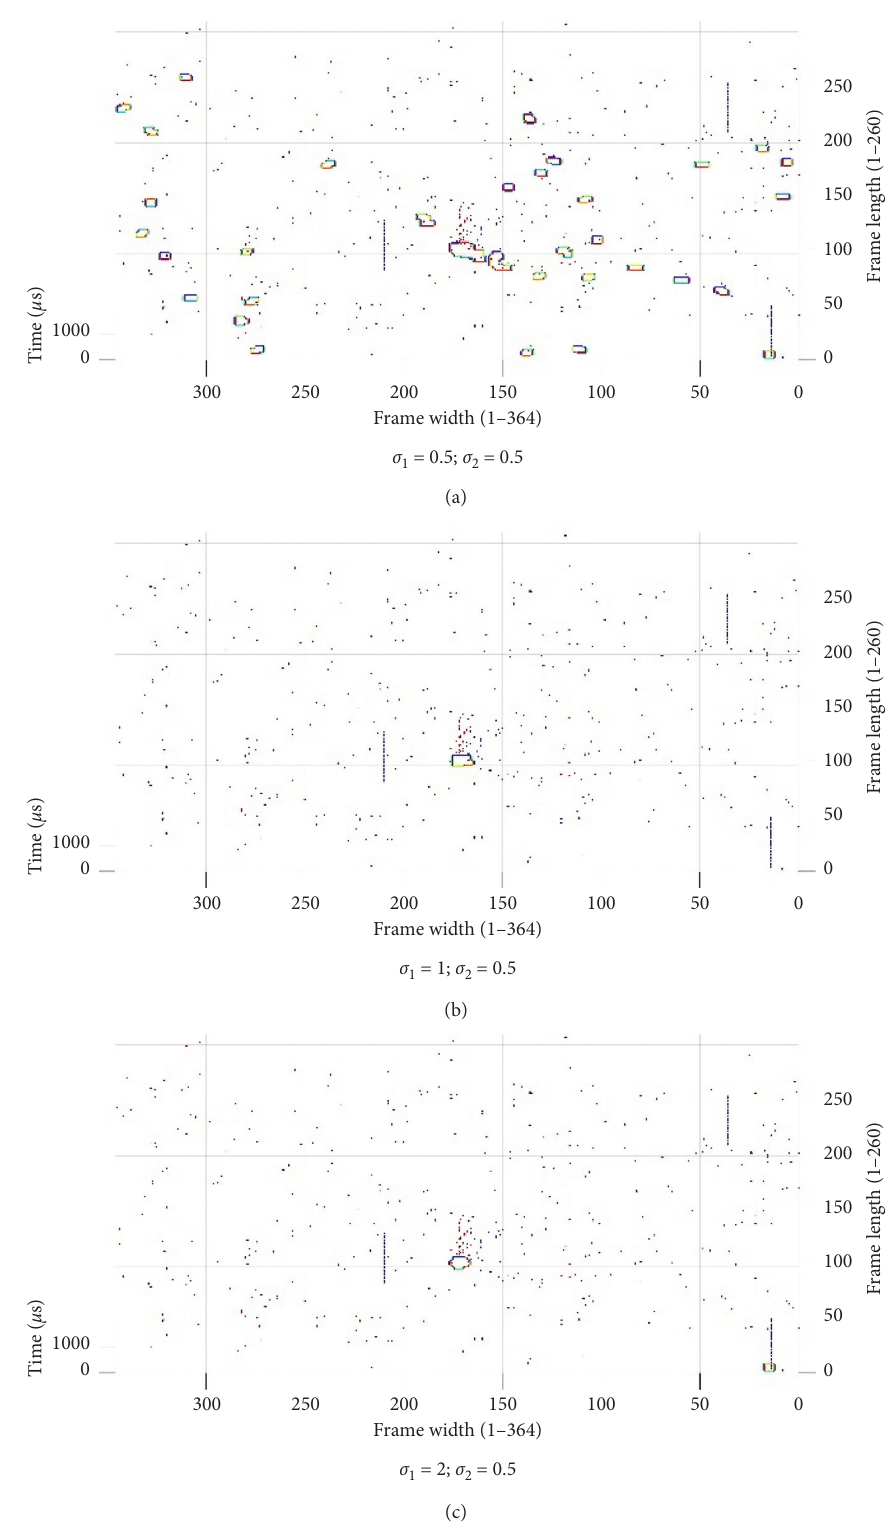
Figure 9: Object events obtained with different σ